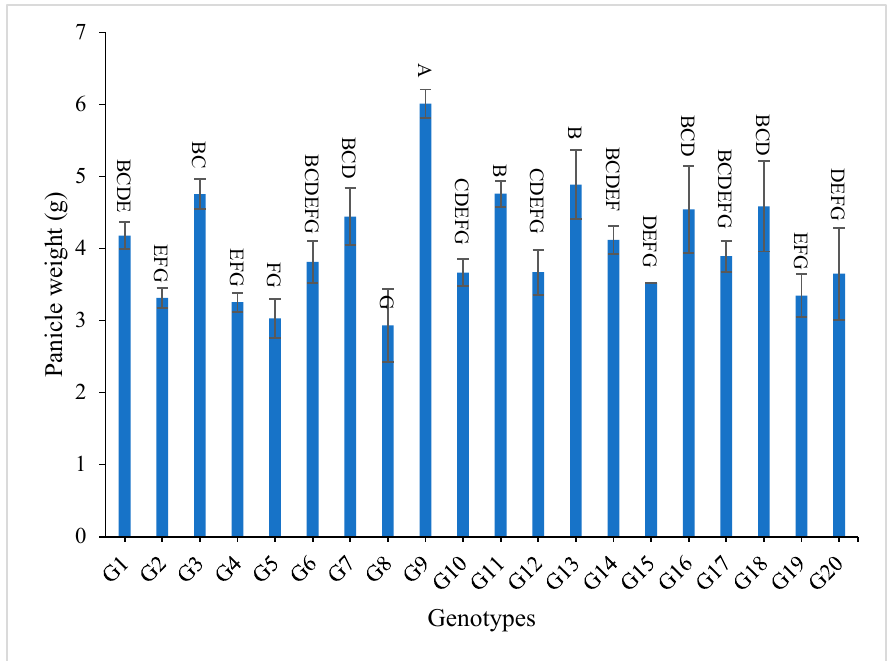
Figure 4. Mean values of panicle weight (g) of twenty rice genotypes over the two years. Bar represents the standard deviation. Different alphabetic letters represent the significant differences among the genotypes at p < 0.05, based on Duncan’s multiple range test.